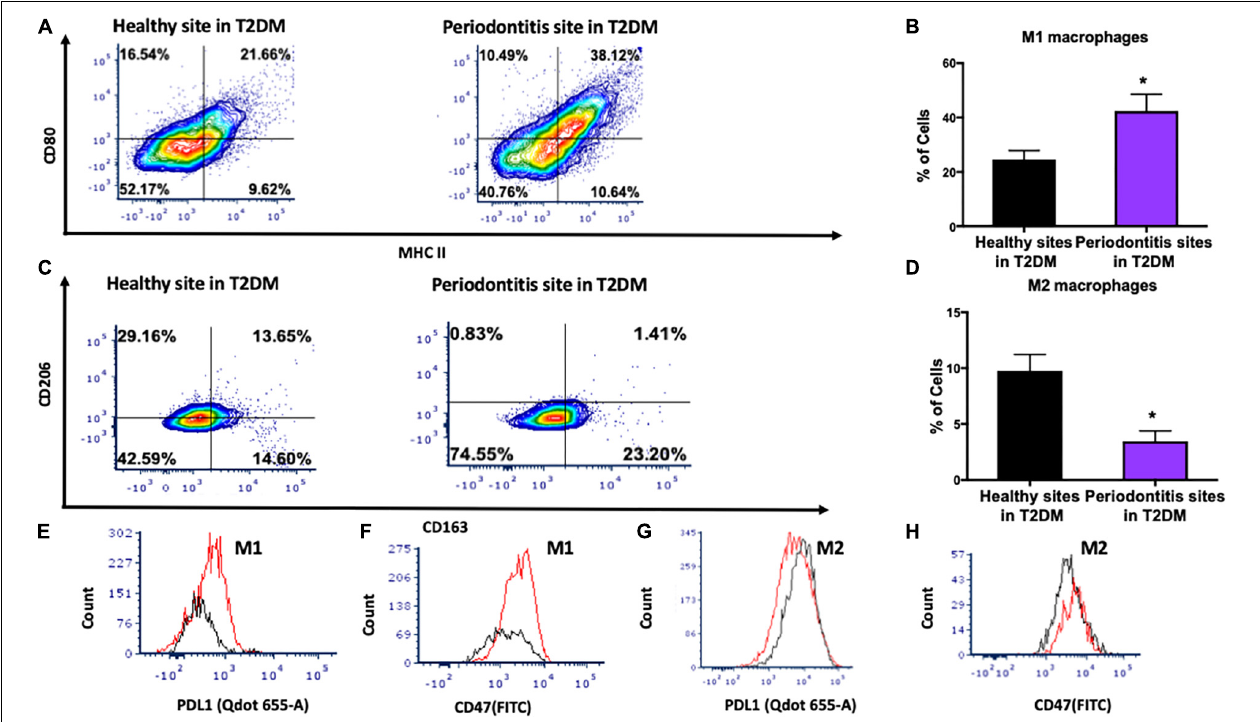
FIGURE 5 | Single cell suspensions from matched periodontitis-affected and healthy gingival tissues from T2DM patients were prepared and stained for UV Zombie, CD45, Lin, CD64, MHC II, CD80, CD163, CD206, PDL1, CD47. (A,B) Representative counter plots of M1 macrophages (CD80 + MHC II + ). Frequency of M1 macrophages was higher in periodontitis-affected tissue compared to control tissue in T2DM ( n = 6 pairs; p < 0.05). (C,D) Representative counter plots of M2 macrophages (CD206 + CD163 + ). Frequency of M2 macrophages was lower in periodontitis-affected tissue compared to control tissue in T2DM ( n = 6 pairs; p < 0.05). (E,F) Flow cytometry histogram of CD47 (FITC) and PDL1 (Qdot 655-A) expression in M1 macrophages in periodontitis-affected tissue (red line) compared to the healthy tissue (black line) shows higher expression of both markers in periodontitis-affected sites in T2DM. The histogram was normalized to the number of events. (G,H) Flow cytometry histogram of CD47 (FITC) and PDL1 (Qdot655-A) expression in M2 macrophages in periodontitis-affected tissue (red line) compared to the healthy tissue (black line) shows change in both markers in periodontitis affected sites in T2DM (the symbol “*” indicates p < 0.05 compared to the healthy